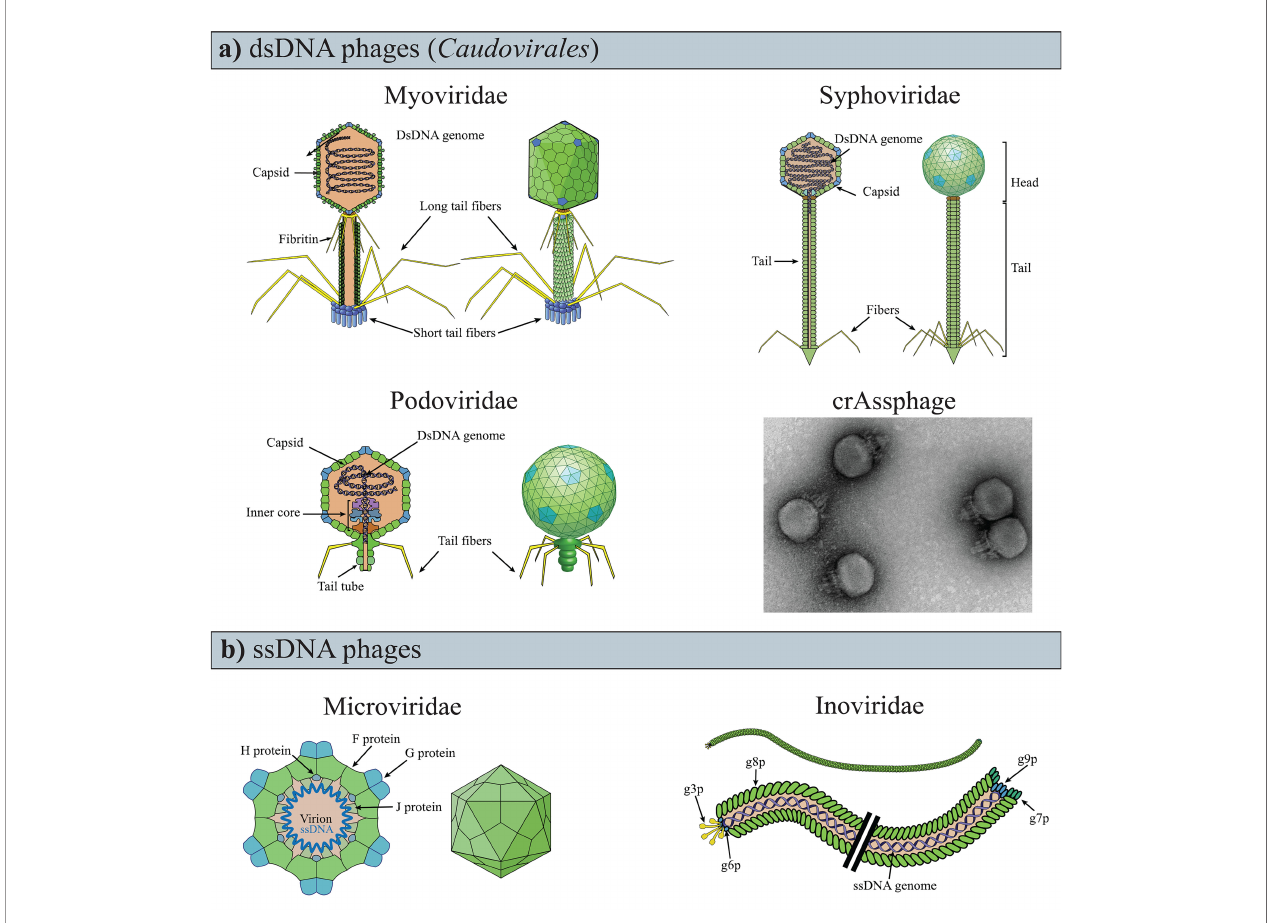
FIGURE 1 | Variability of phage genomes and capsids within the known gut phages. (A) dsDNA phages of the Caudovirales order have a polyhedral capsid to which is attached a tail, the representative feature of the order. (B) TEM image of crAssphage ( F crAss001), negatively contrasted with uranyl acetate. Image modi fi ed from ref (Shkoporov et al., 2018a). (C) ssDNA phages are currently recognized as having either icosahedral or fi lamentous capsids (i.e., Microviridae and Inoviridae , respectively). The drawings of the phages were obtained and modi fi ed from ViralZone, SIB Swiss Institute of Bioinformatics (Hulo et al.,